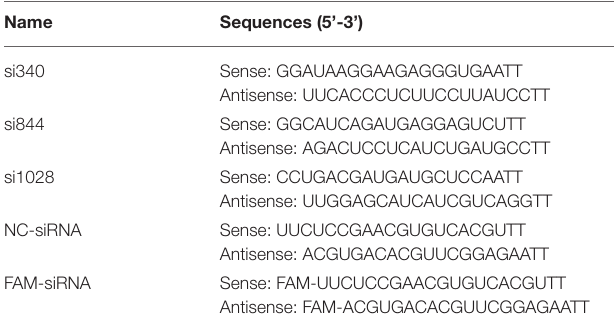
TABLE 1 | The siRNA primers used for the target and reference genes (experiments 2 and 3). Name